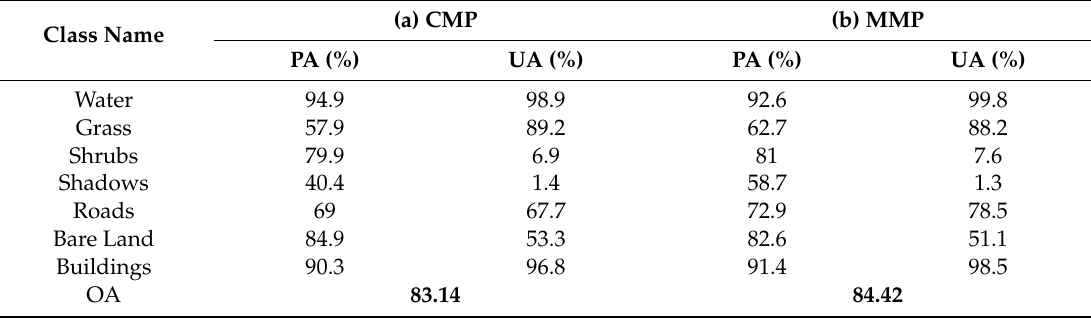
Table 6. The (a) CMP and (b) MMP classification accuracy results over Boksburg.